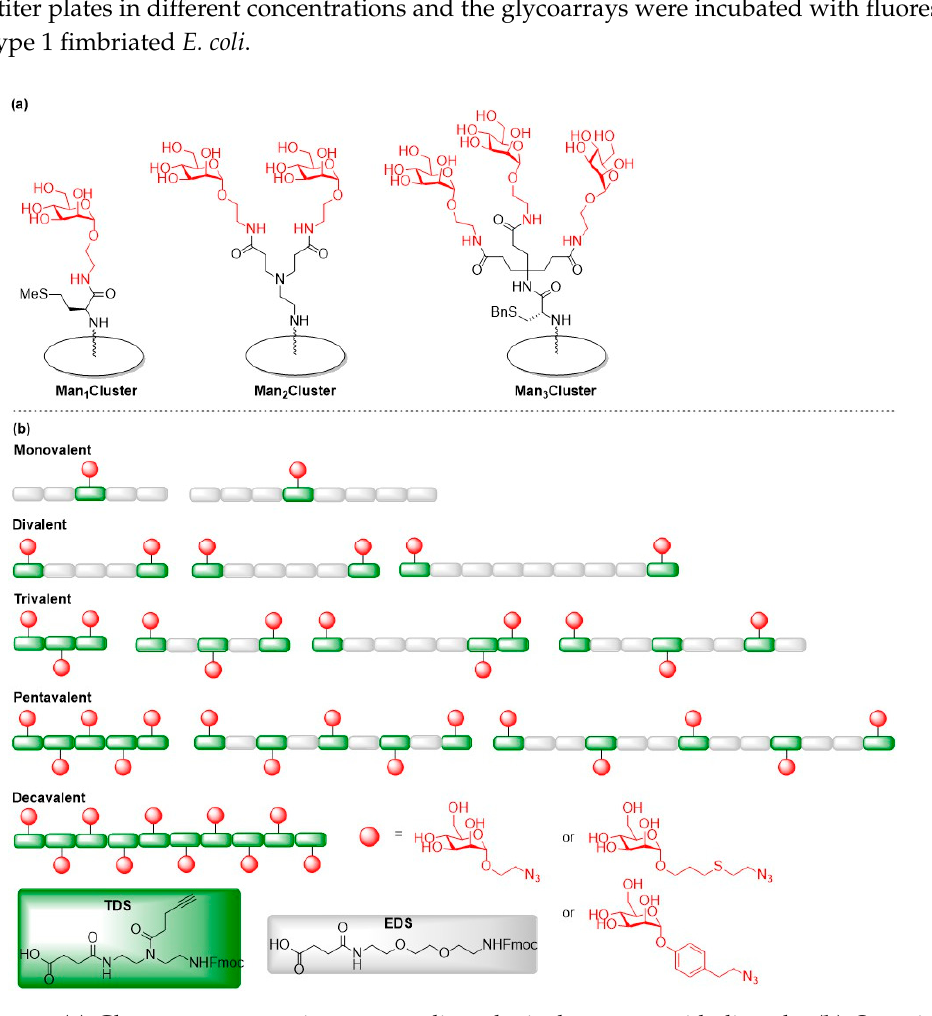
Figure 2. ( a ) Glycoarrays presenting mono-, di- and trivalent mannoside ligands; ( b ) Overview of linear glycomacromolecules carrying α -D-mannose ligands with varied ligand valency and interligand spacing.